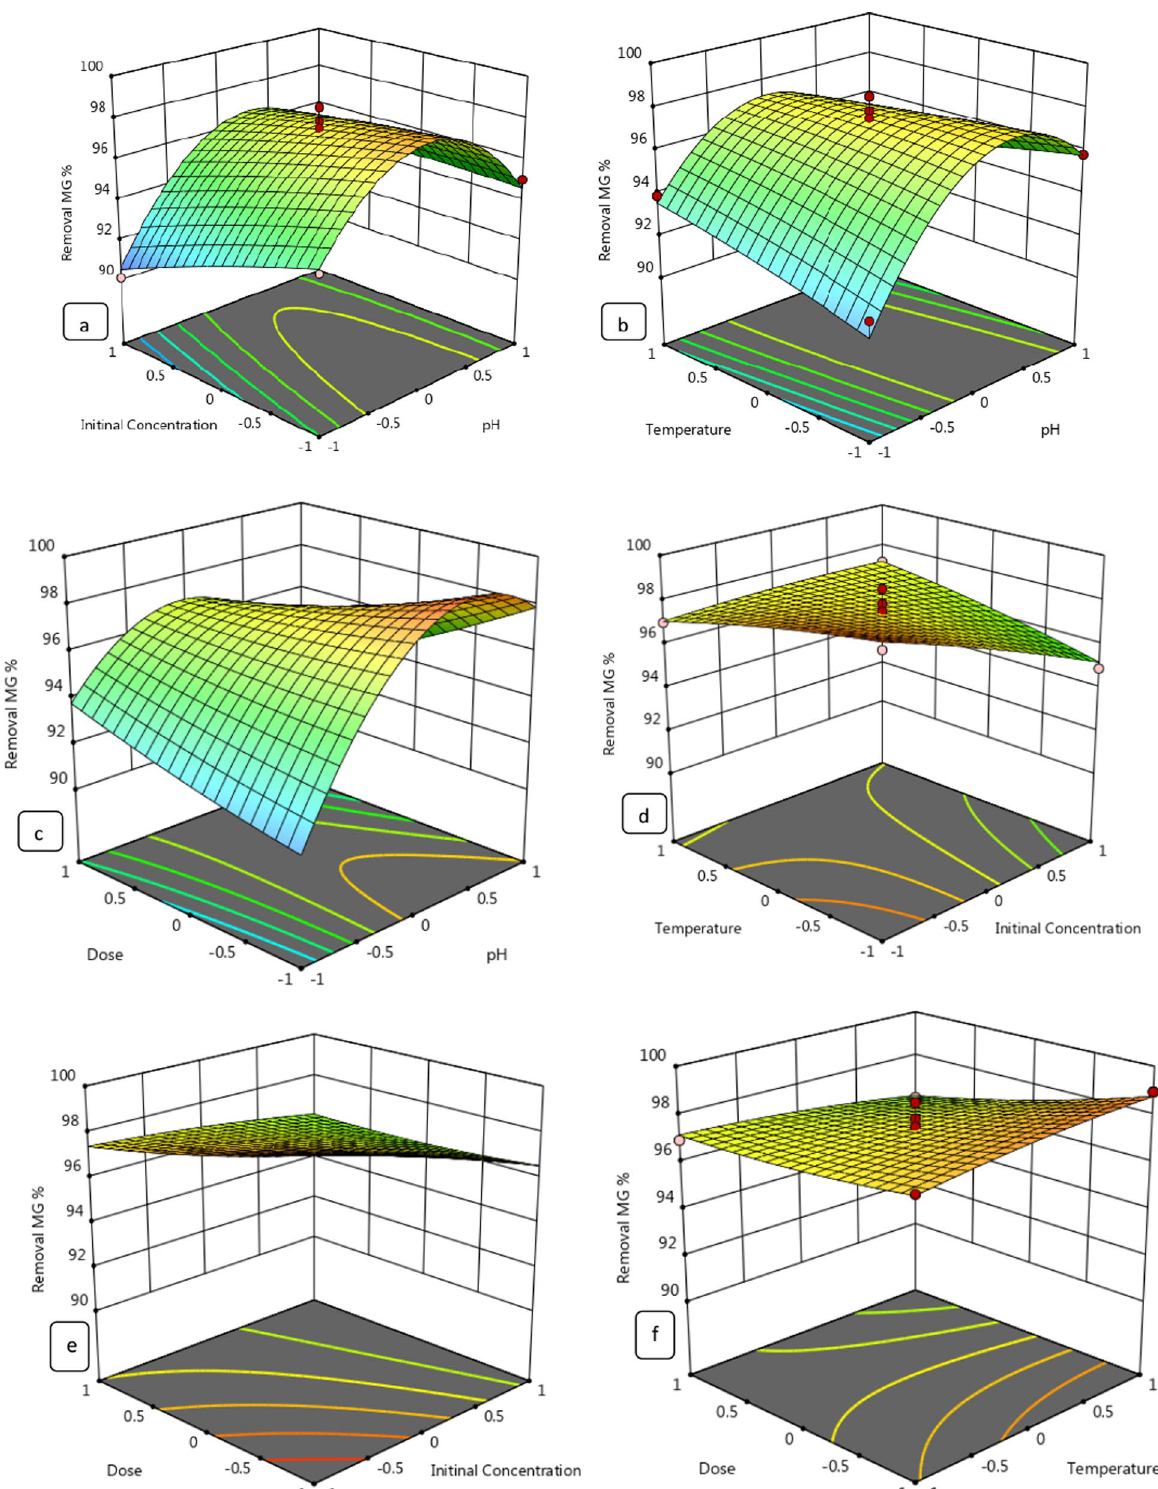
Fig. 13. 3D response surface plot of MG removal % through MgO impregnated clay as a function of pH, temperature and adsorbent